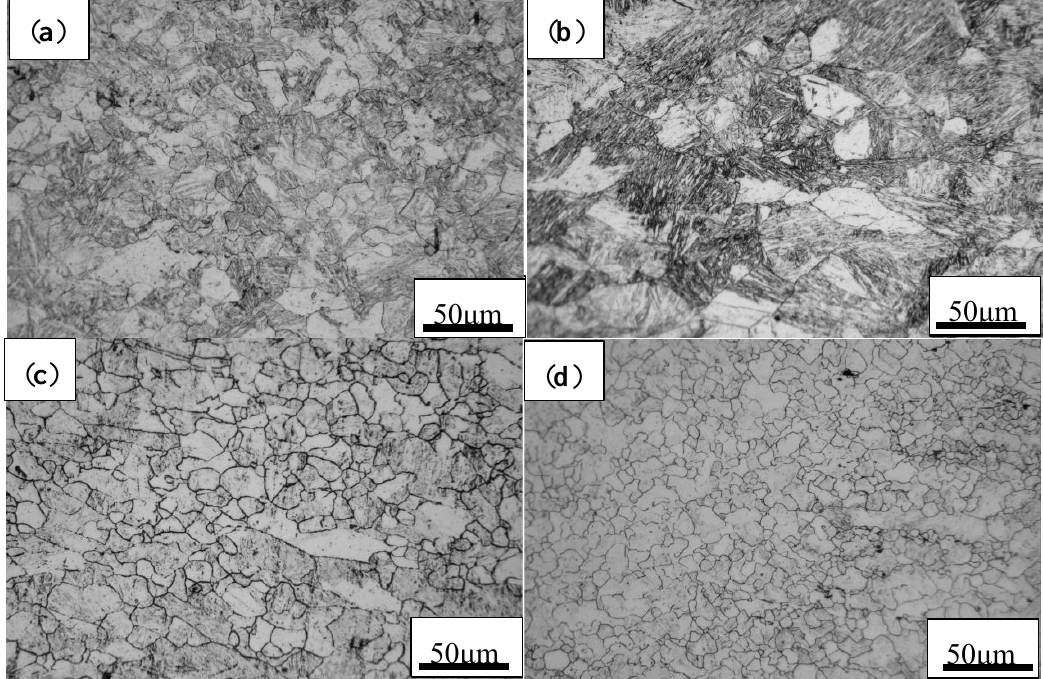
Figure 14. LM micrographs of the examined steel after hot deformation under different conditions: ( a ) 950 °C and 0.005 s − 1 , ( b ) 950 °C and 10 s − 1 , ( c ) 1050 °C and 0.1 s − 1 and ( d ) 1000 °C and 0.1 s − 1 .